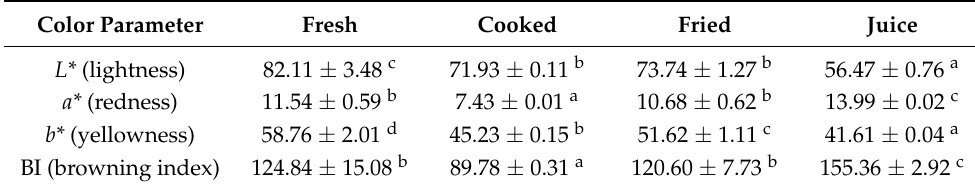
Table 1. Color parameters in L*a*b* space of fresh quince fruits and quince products. Color Parameter Fresh Cooked